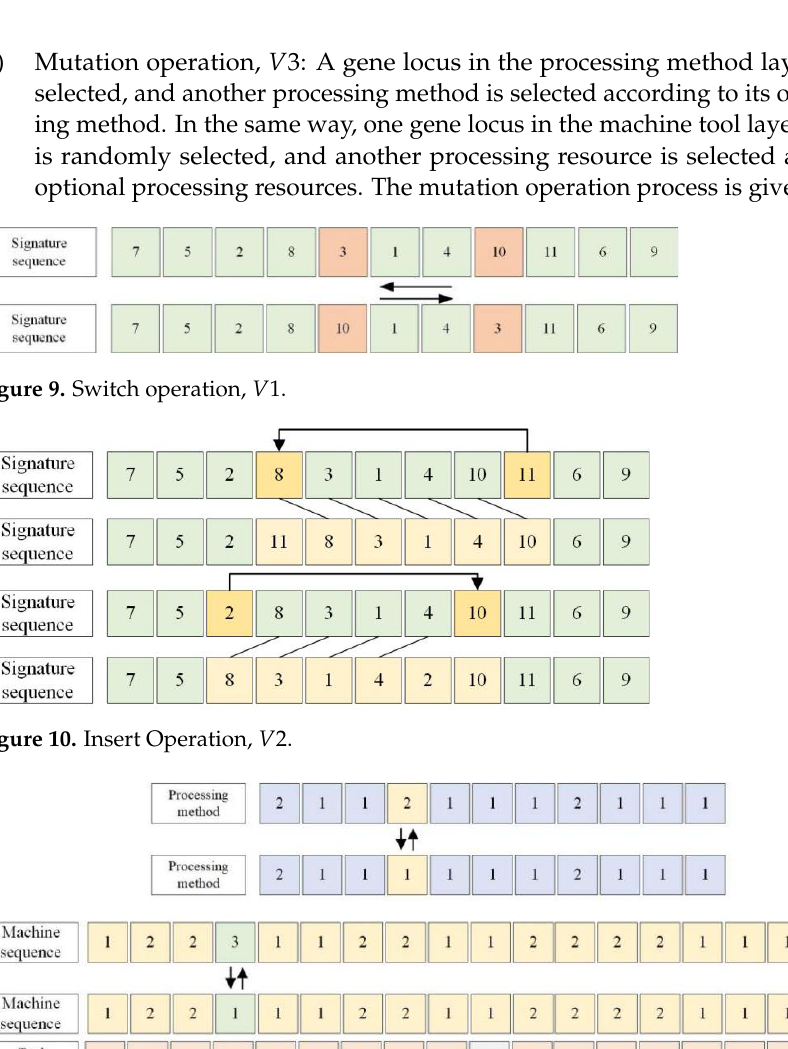
Figure 9. Switch operation, 1 V .